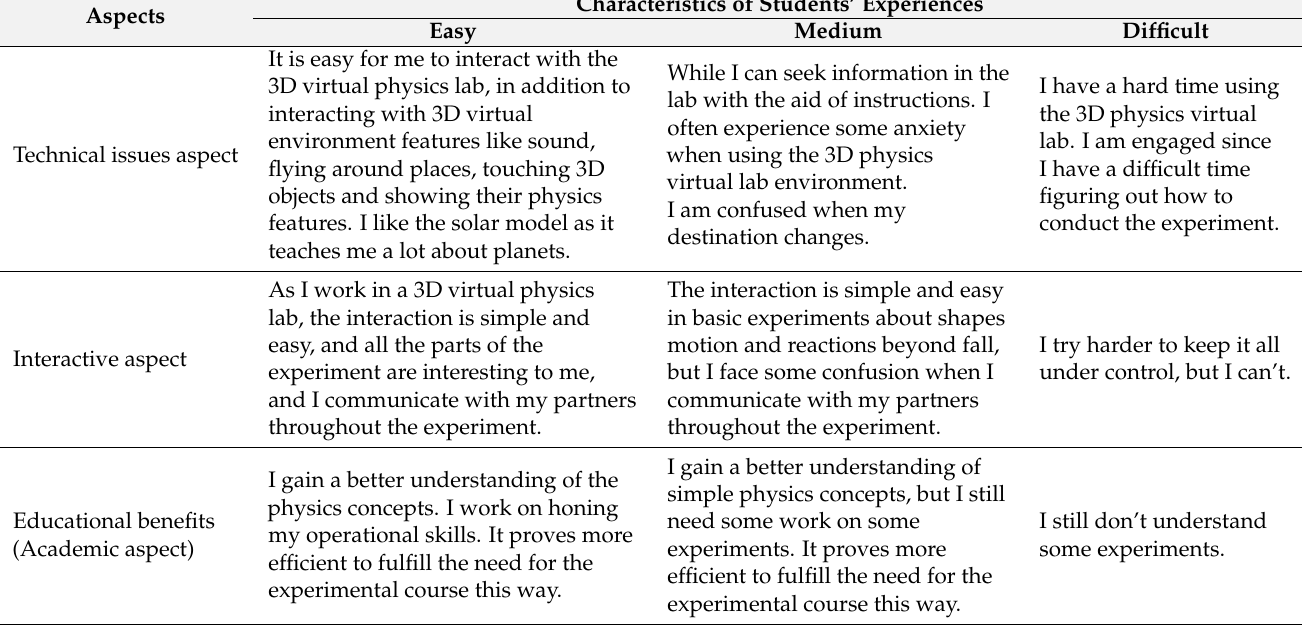
Figure 4. Academic Aspect of 3D virtual laboratory. Table 13. Experience of a student with disabilities in 3D virtual physics